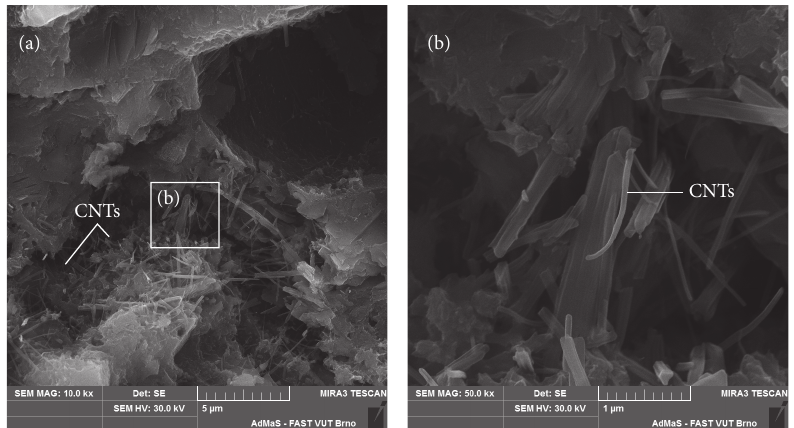
Figure 8: (a) SEM images of CNT enhanced cement mortar’s microstructure, magnified 10,000 times. (b) SEM images of CNT enhanced cement mortar’s microstructure, magnified 50,000